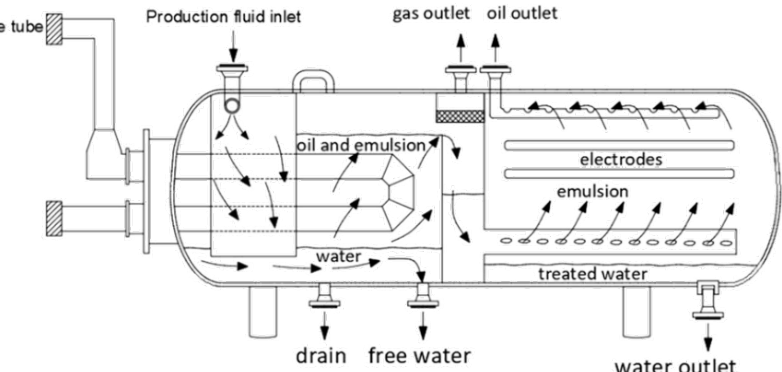
Figure 10. Schematic of the flow diagram for electrostatic heater. Reproduced with permission from Choudhary et al., 2017. Creative Commons Attribution 3.0 licence 2017, IOP Publishing Ltd. [188,189].